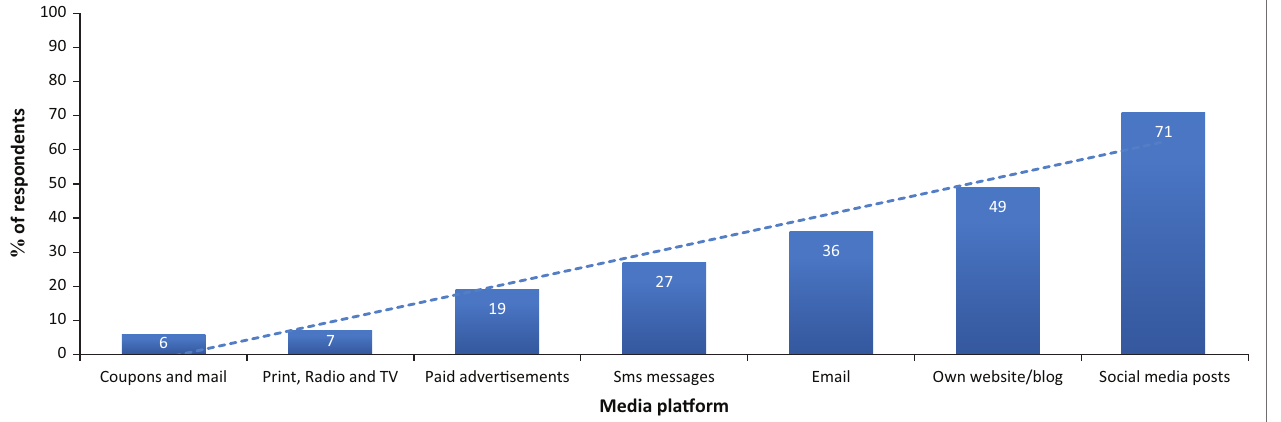
FIG URE 2: Channels used for customer